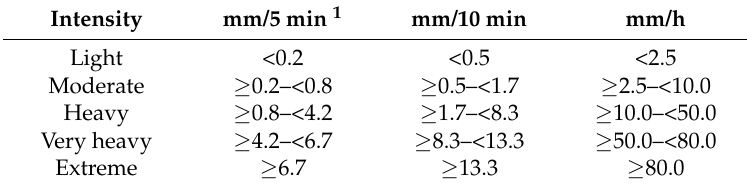
Table 1. The classification of the intensity of precipitation per time unit